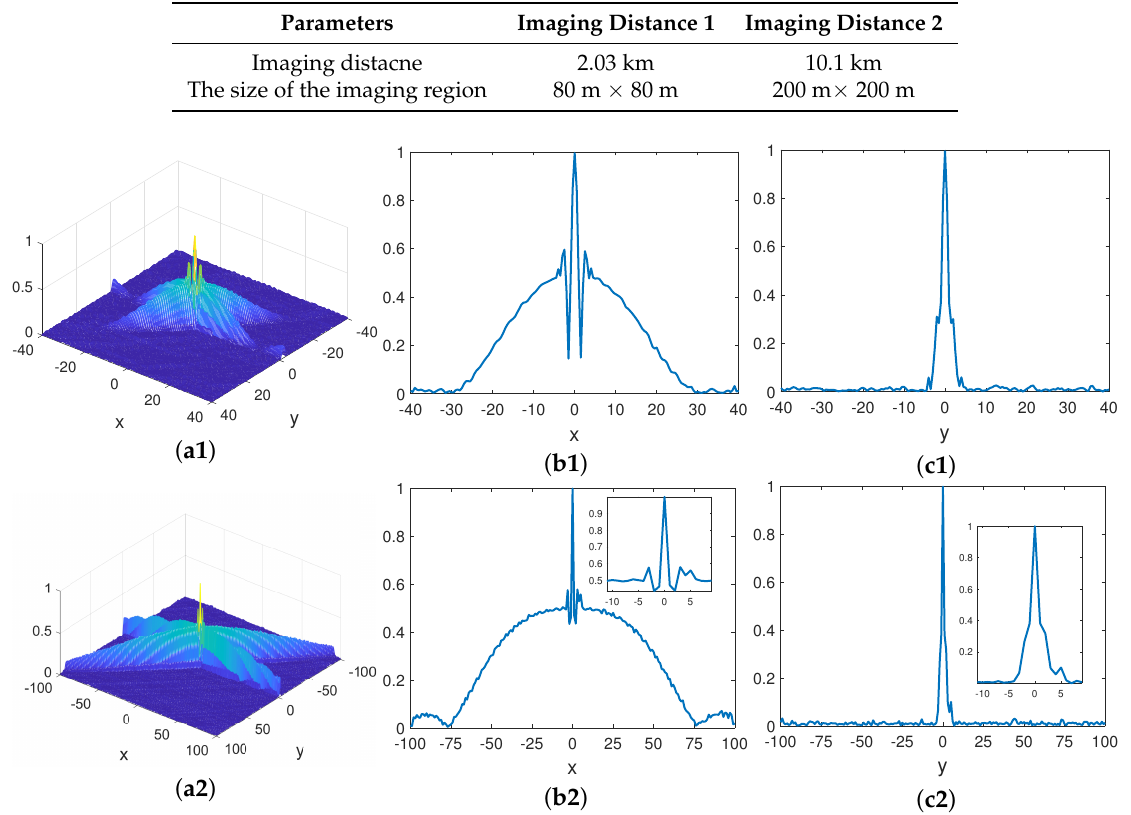
Table 5. Parameters of imaging distance and imaging region in this subsection.